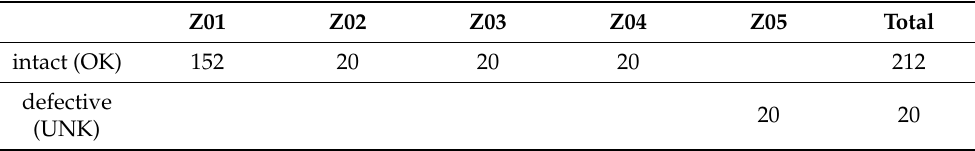
Table 3. Sample size of Sinc-150k, where Z01–Z05 refers to the number of cogwheels.